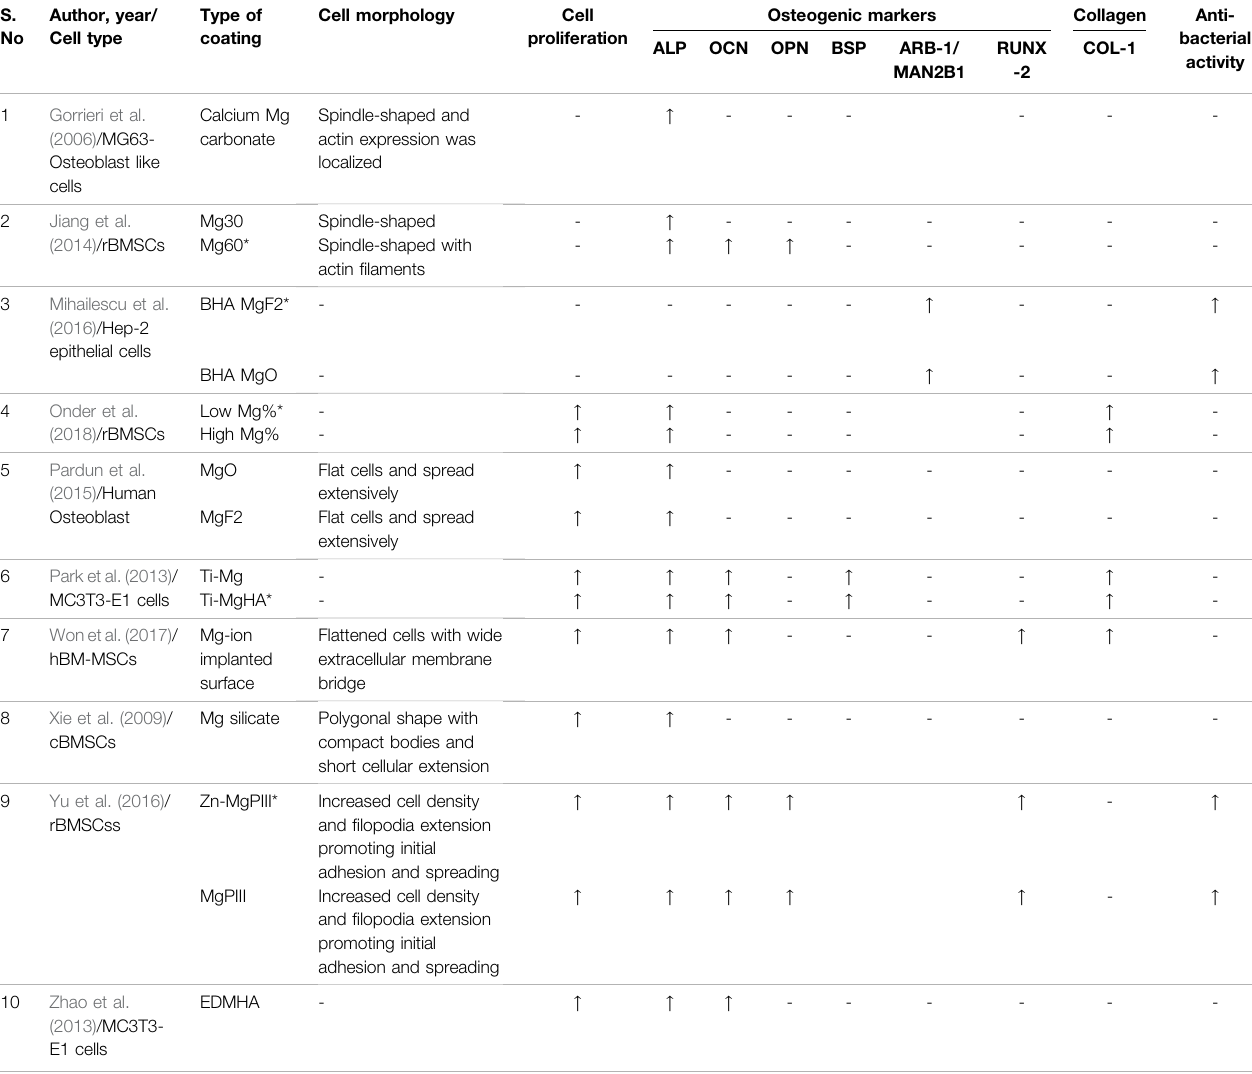
TABLE 2 | Summary of results of in vitro studies observed for main outcome measures in Magnesium-based